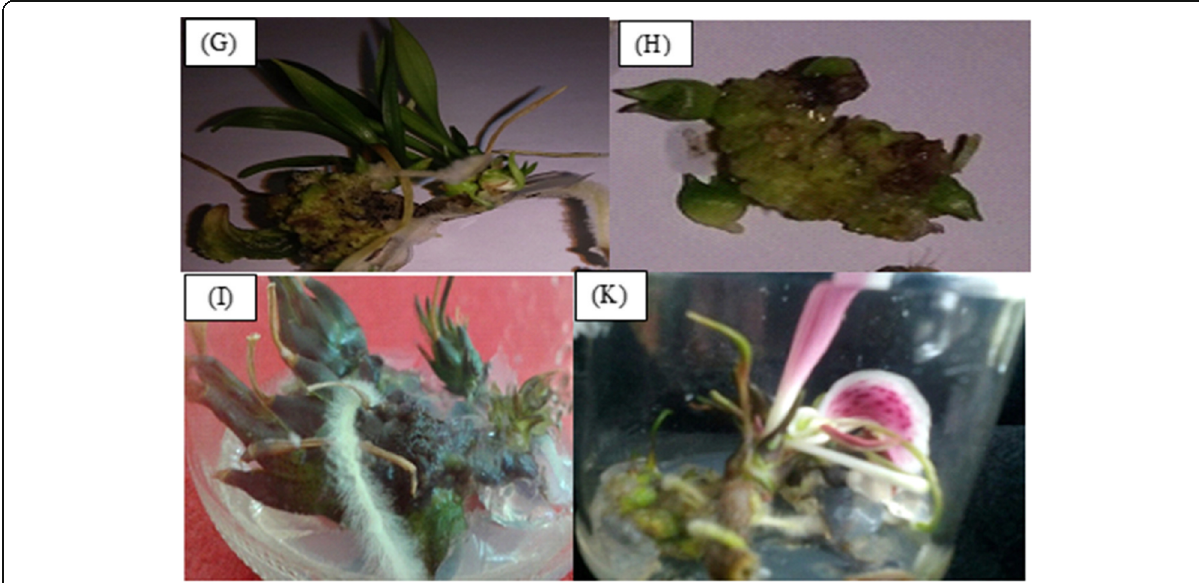
Fig. 4 Development of Lilium bulblets during three repeated subcultures. g – i In vitro proliferation of shootlets and bulblets during second subculture on MS culture medium supplemented with 120 g/l sucrose. k In vitro flowering after 3 months on the same